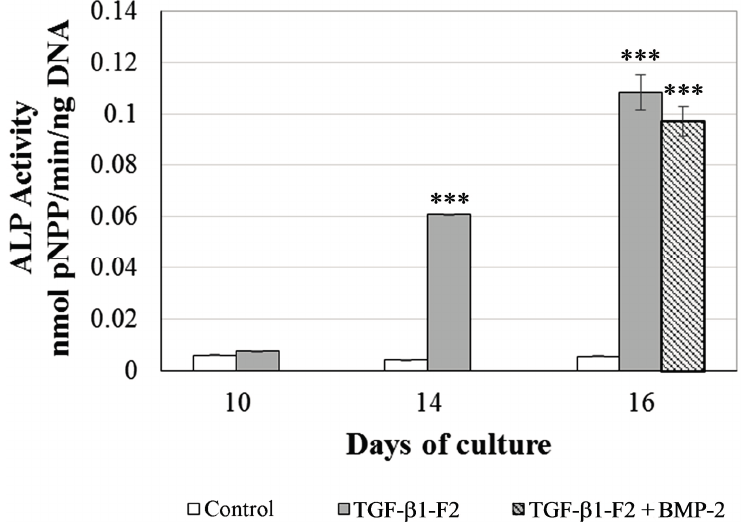
Figure 5. Effects of culture conditions on ALP (alkaline phosphatase activity) activity. Values represent the means ± SD, n = 3; *** p < 0.001. pNPP: p